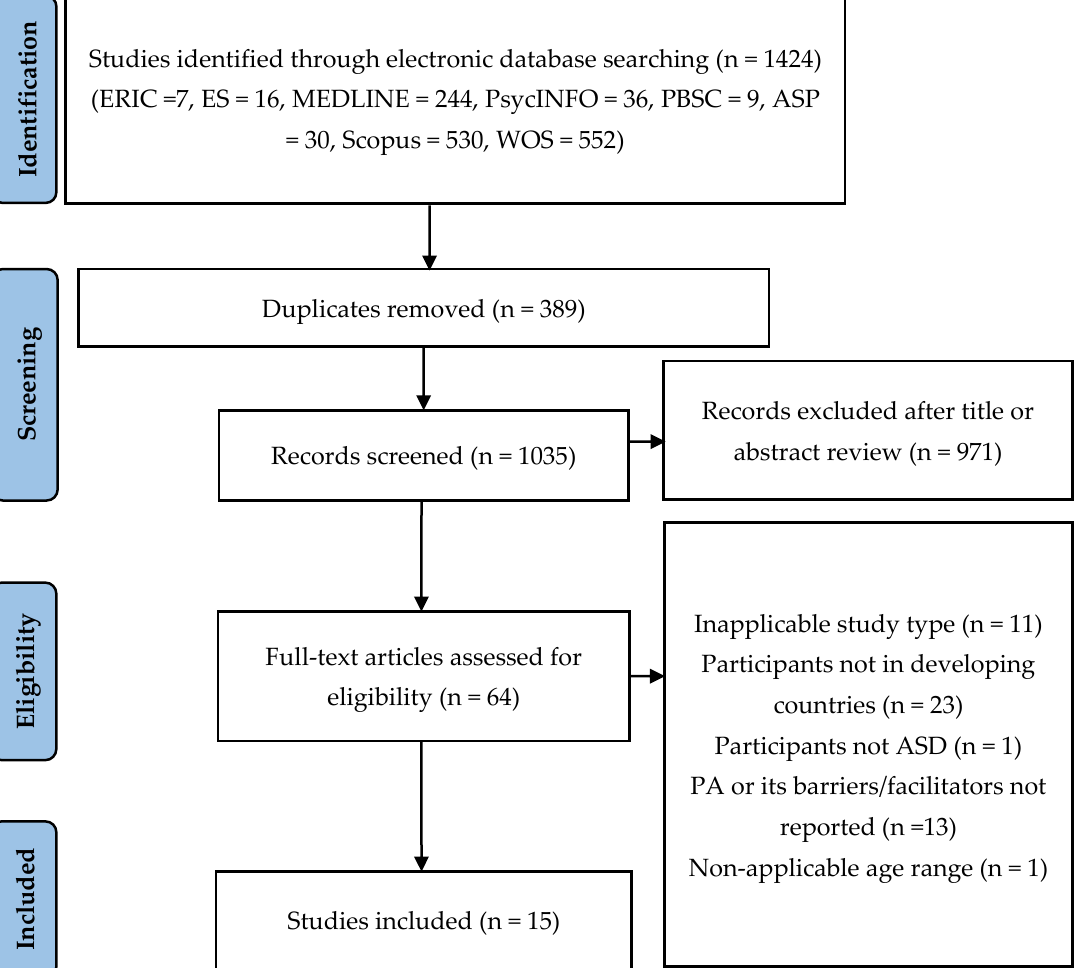
Figure 1. Flowchart of search and study selection.